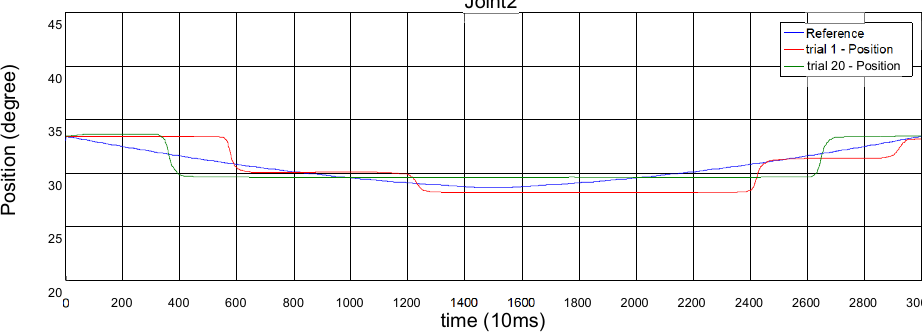
Figure 24. Trajectory 1—2nd-axis (load-on) ILC trial 1 and trial 20 tracking and error diagrams. Figure 25. Trajectory 1—3rd-axis (load-on) ILC trial 1 and trial 20 tracking and error diagrams.